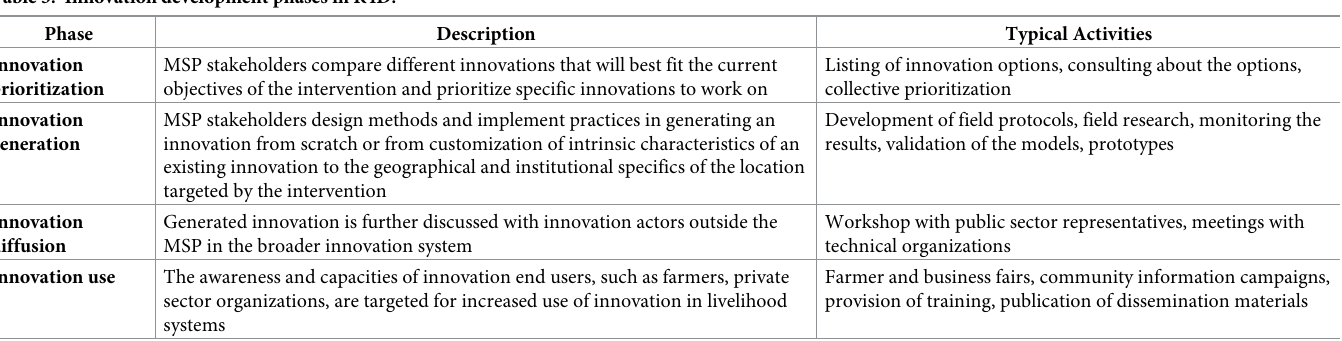
Table 3. Innovation development phases in R4D.